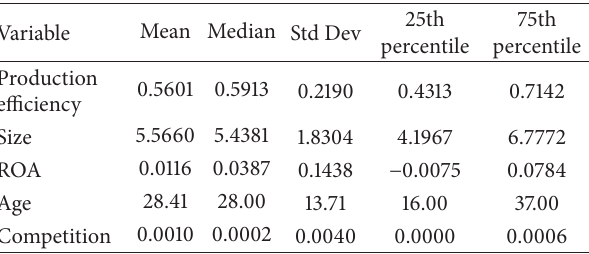
Table 2: Descriptive statistics ( 𝑁 =